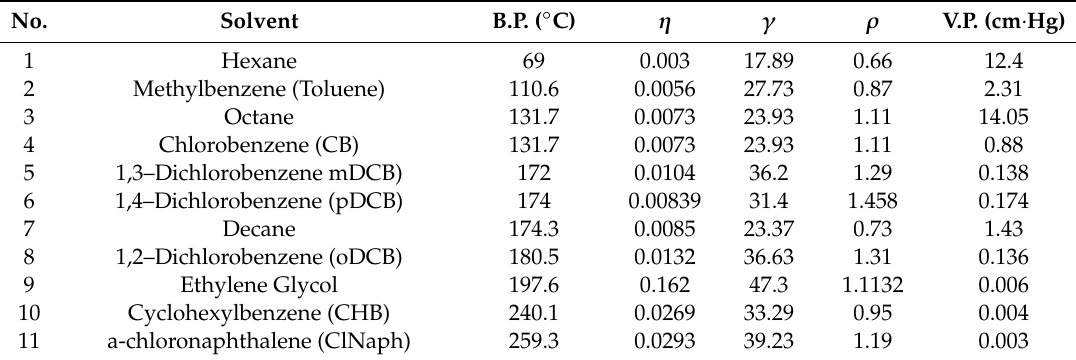
Table 3. Re number and Oh number of the cosolvent inks depending on the mix ratio of hexane and oDCB.